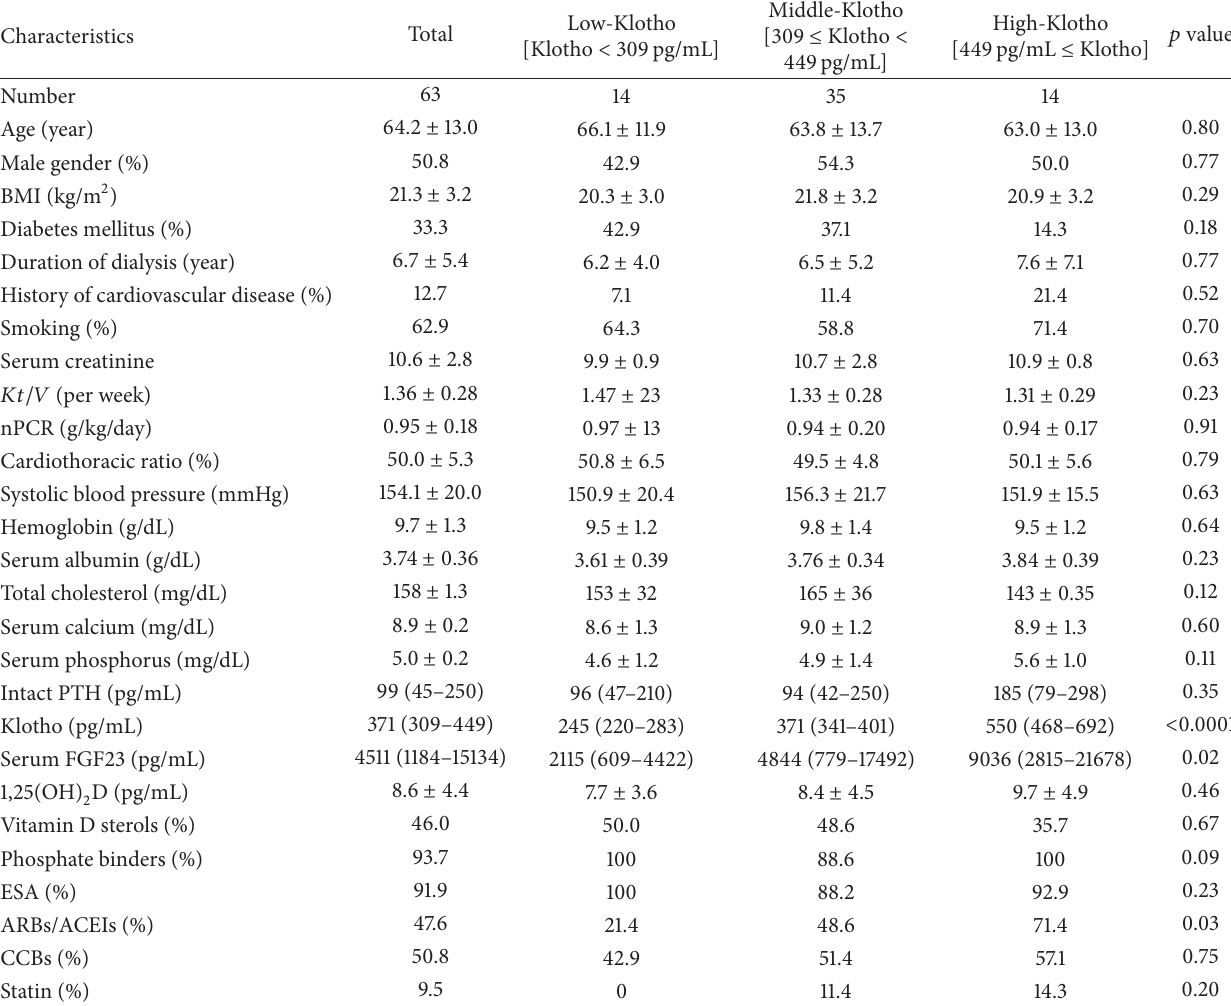
Table 1: Demographic and clinical characteristics of patients according to study